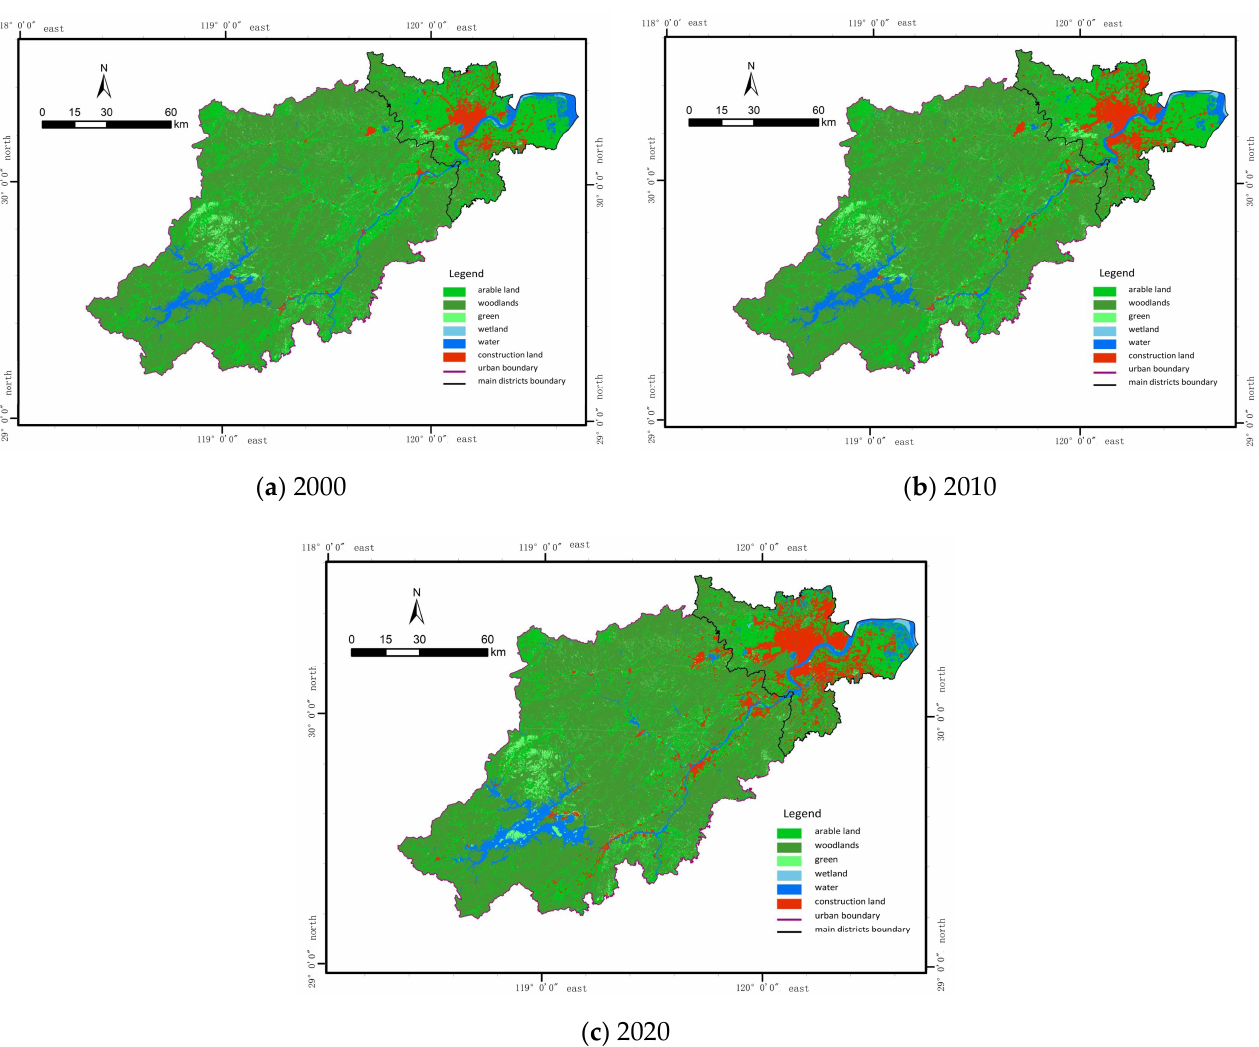
Figure 1. Distribution of landscape types in Hangzhou from 2000 to 2020.